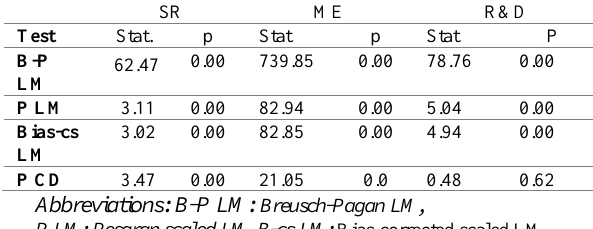
Table 3. Cross-sectional dependence test results of Model 1